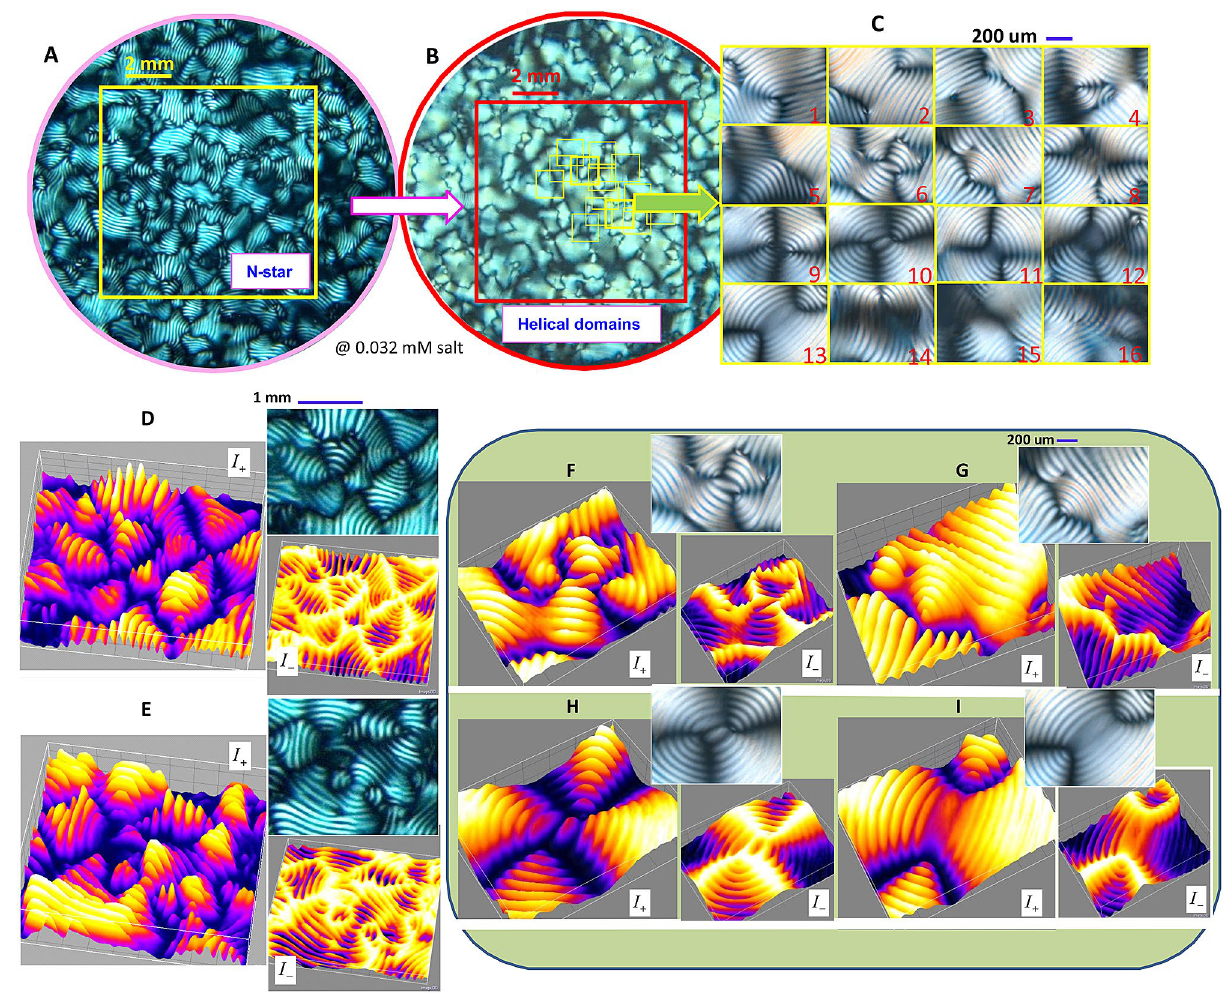
Figure 6. The replica (or self-similarity) of equilibrium states of chiral patterns of N-star (N*) phase: ( A ) and the helical domains ( B , C ) at an ionic strength of 0.032 mM salt, with depolarized optical morphologies: The corresponding optical morphologies are enhanced with positive and negative 3D intensity maps of I + , and I − for the local view of the N-star (N*) phase ( D,E ) and the varieties of helical domains ( F – I ) respectively, by a software version ImageJ 1.52i in the URL link https ://image j.nih.gov/ij/. Note that cavity current loops are visible in both panels of ( G , H ), at the center of helical domains, which may also be related to the occasional voids in the phase diagram, as the resultant LTKA1 that can be seen in the Supplementary Data Movie